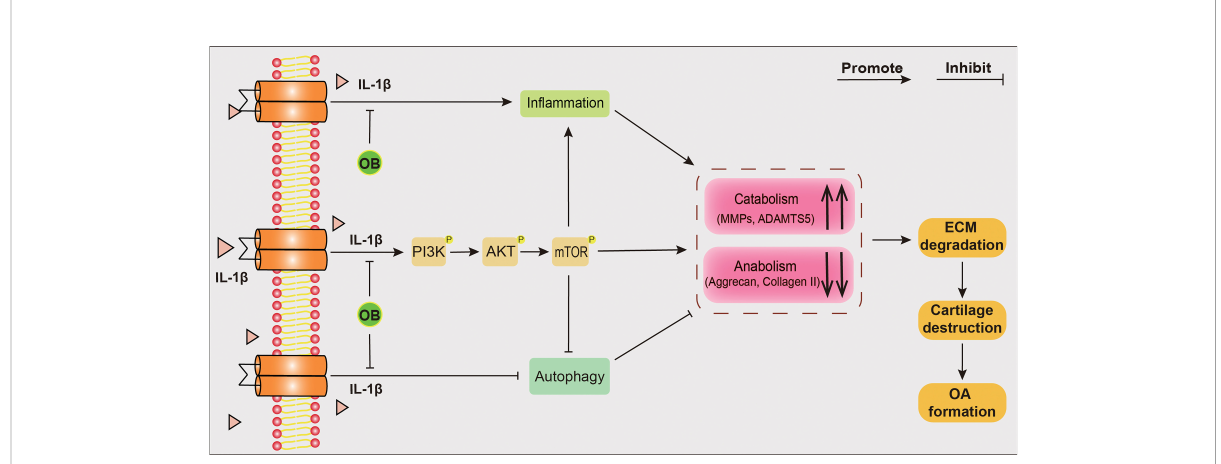
FIGURE 9 Schematic diagram of the chondroprotective effect of OB on mice OA. IL-1 b – induced OA chondrocytes were employed in in vitro experiments. The anabolism – inhibiting, catabolism – enhancing, and in fl ammation-promoting effects induced by IL-1 b could be reversed after the treatment of OB. Mechanistically, OB inhibted the activation of PI3K/AKT/mTOR signaling and restored the reduced autophagy process in IL-1 b induced chondrocytes. However, 3-MA, an autophagy inhibitor, abolished the protective effect of OB on cartilage, indicating that OB plays a protecting role in articular cartilage through the autophagy